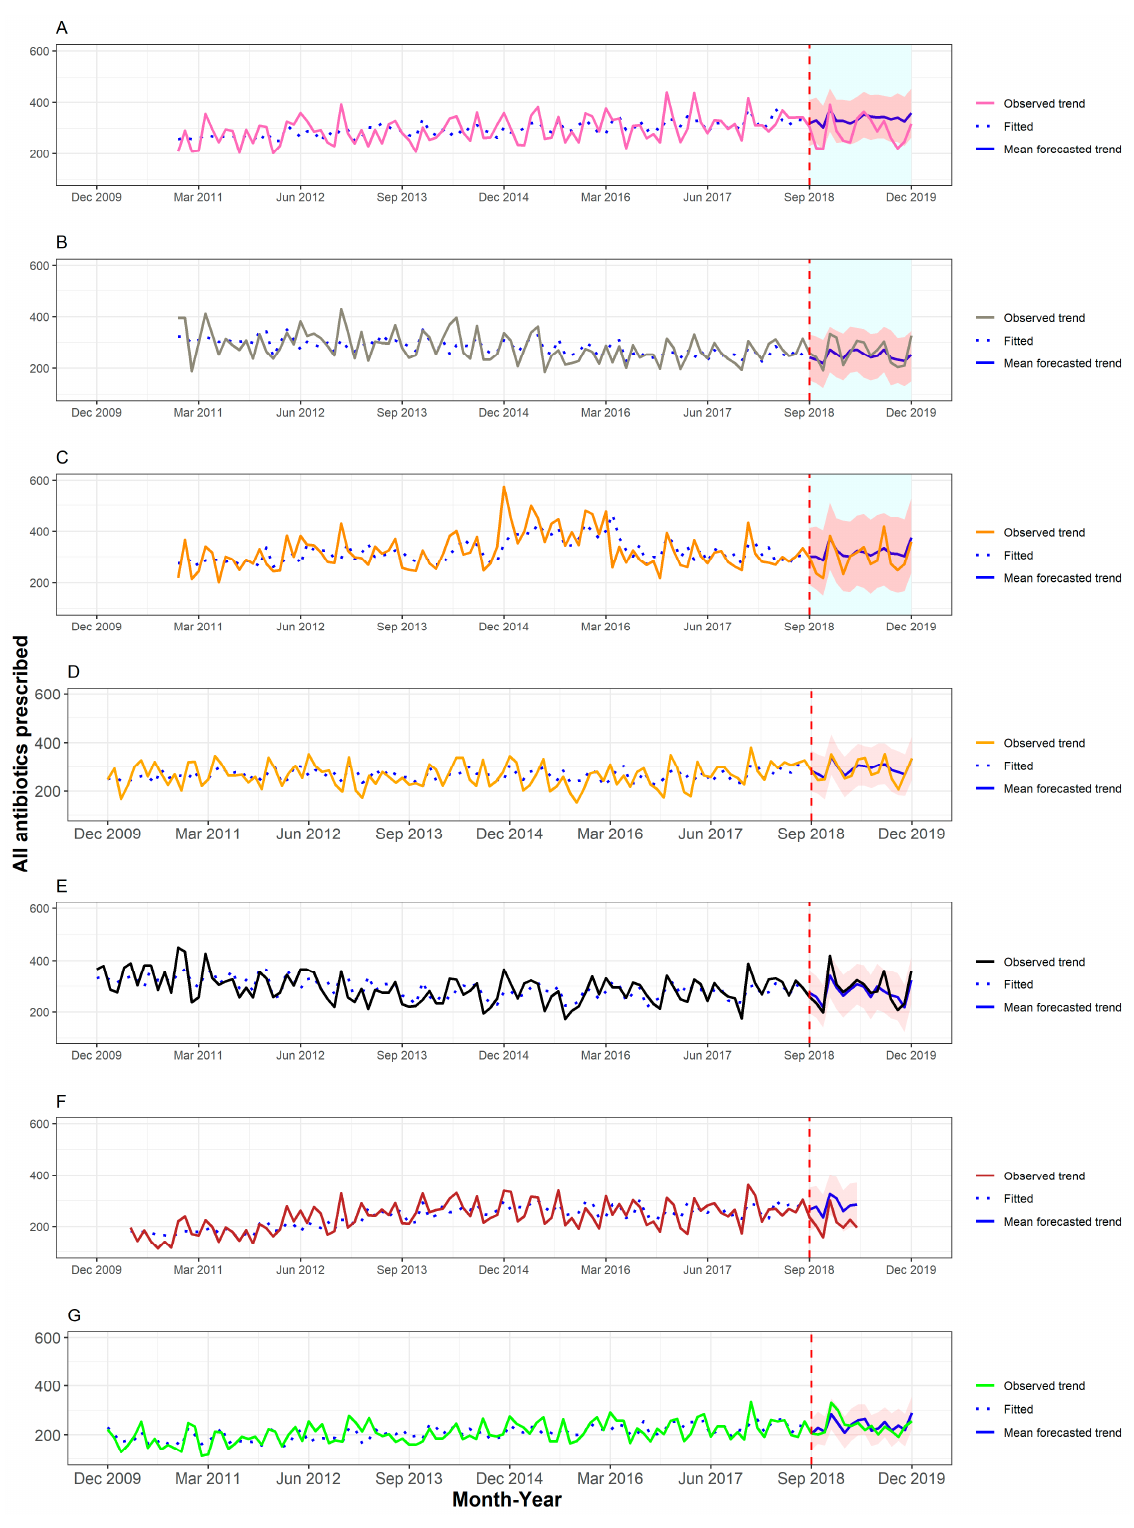
Figure 1. Time series for all antibiotics prescribed for adult patients across the different OOH primary care locations with CRP machines, ( A – C ), and those without CRP machines, ( D – G ). The fitted values obtained from the ARIMA models are depicted using a dotted blue line (pre-September 2018), and the forecasted mean trends are depicted using a solid blue line (post-September 2018), with the corresponding 95% confidence interval highlighted in red.